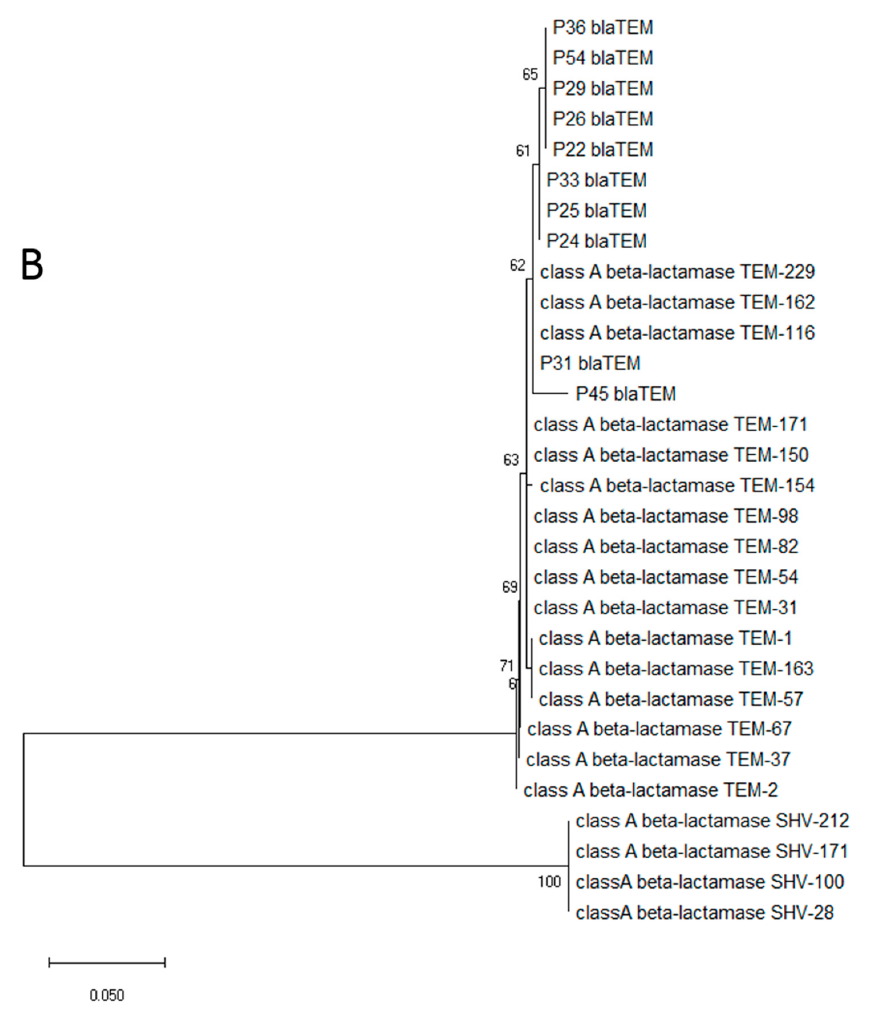
Figure 4. Detection of extended-spectrum β -lactamases (ESBLs) belonging to class A and Metallo- β -lactamases (MBLs) belonging to class B in B. cereus s.l. ( A ) and K. cowanii isolates ( B ) from chili powder. β -lactamases from isolates are indicated as blaA / blaB and isolate number ( A ), and as blaTEM in ( B ). Class A beta-lactamase SHV was included for the phylogenetic analysis.